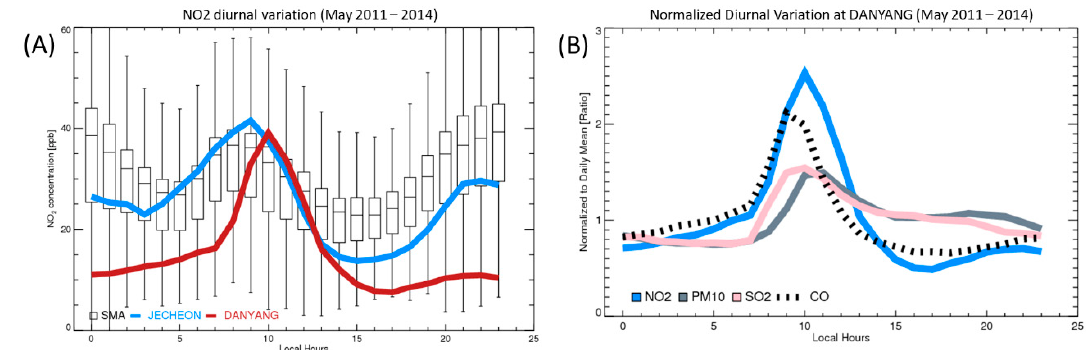
Figure 3. ( A ) Annual variation in OMI NO 2 VCD over the Seoul Metropolitan Area (SMA), YDJ, YDJ (kilns), and YDJ NO x emissions (six cement kilns, CAPSS 2010). Inter-annual changes in OMI and CMAQ NO 2 VCDs (April to June 2005–2015) ( B ) over the SMA and ( C ) over the YDJ.